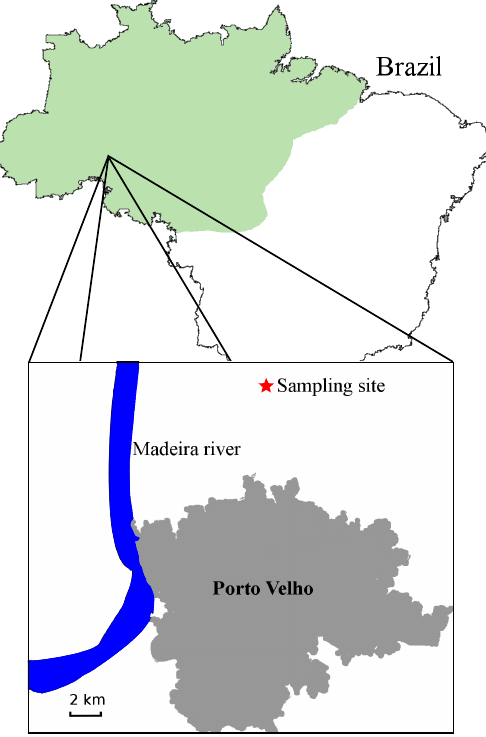
Figure 1. Map of Brazil indicating the Amazon region (in green) and detailed view of the city of Porto Velho and the sampling